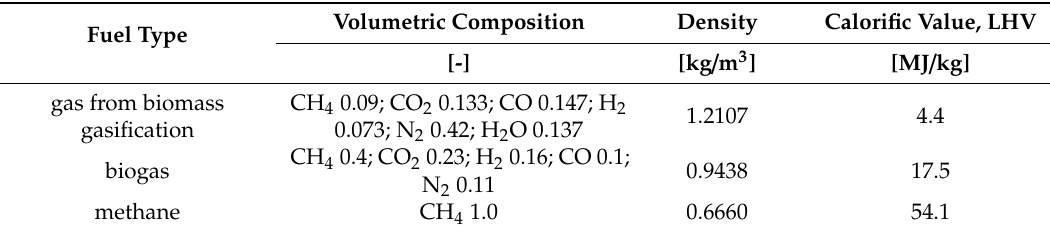
Table 4. The list of analyzed gases with di ff erent heating values